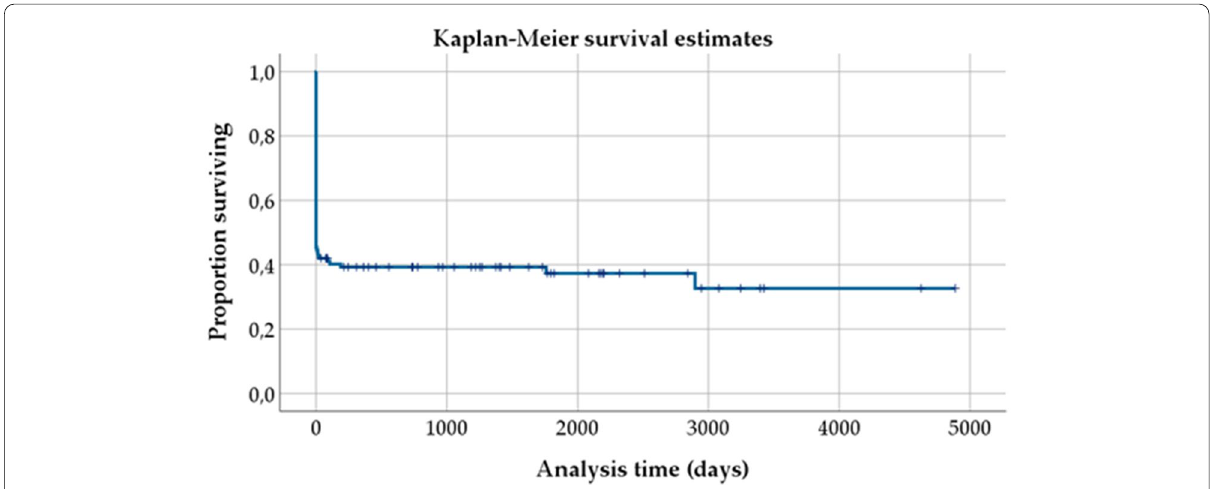
Fig. 1 Kaplan–Meier estimation of survival over follow-up time. Figure 1 shows the overall survival (in days) after onset of pulmonary embolism until the time of